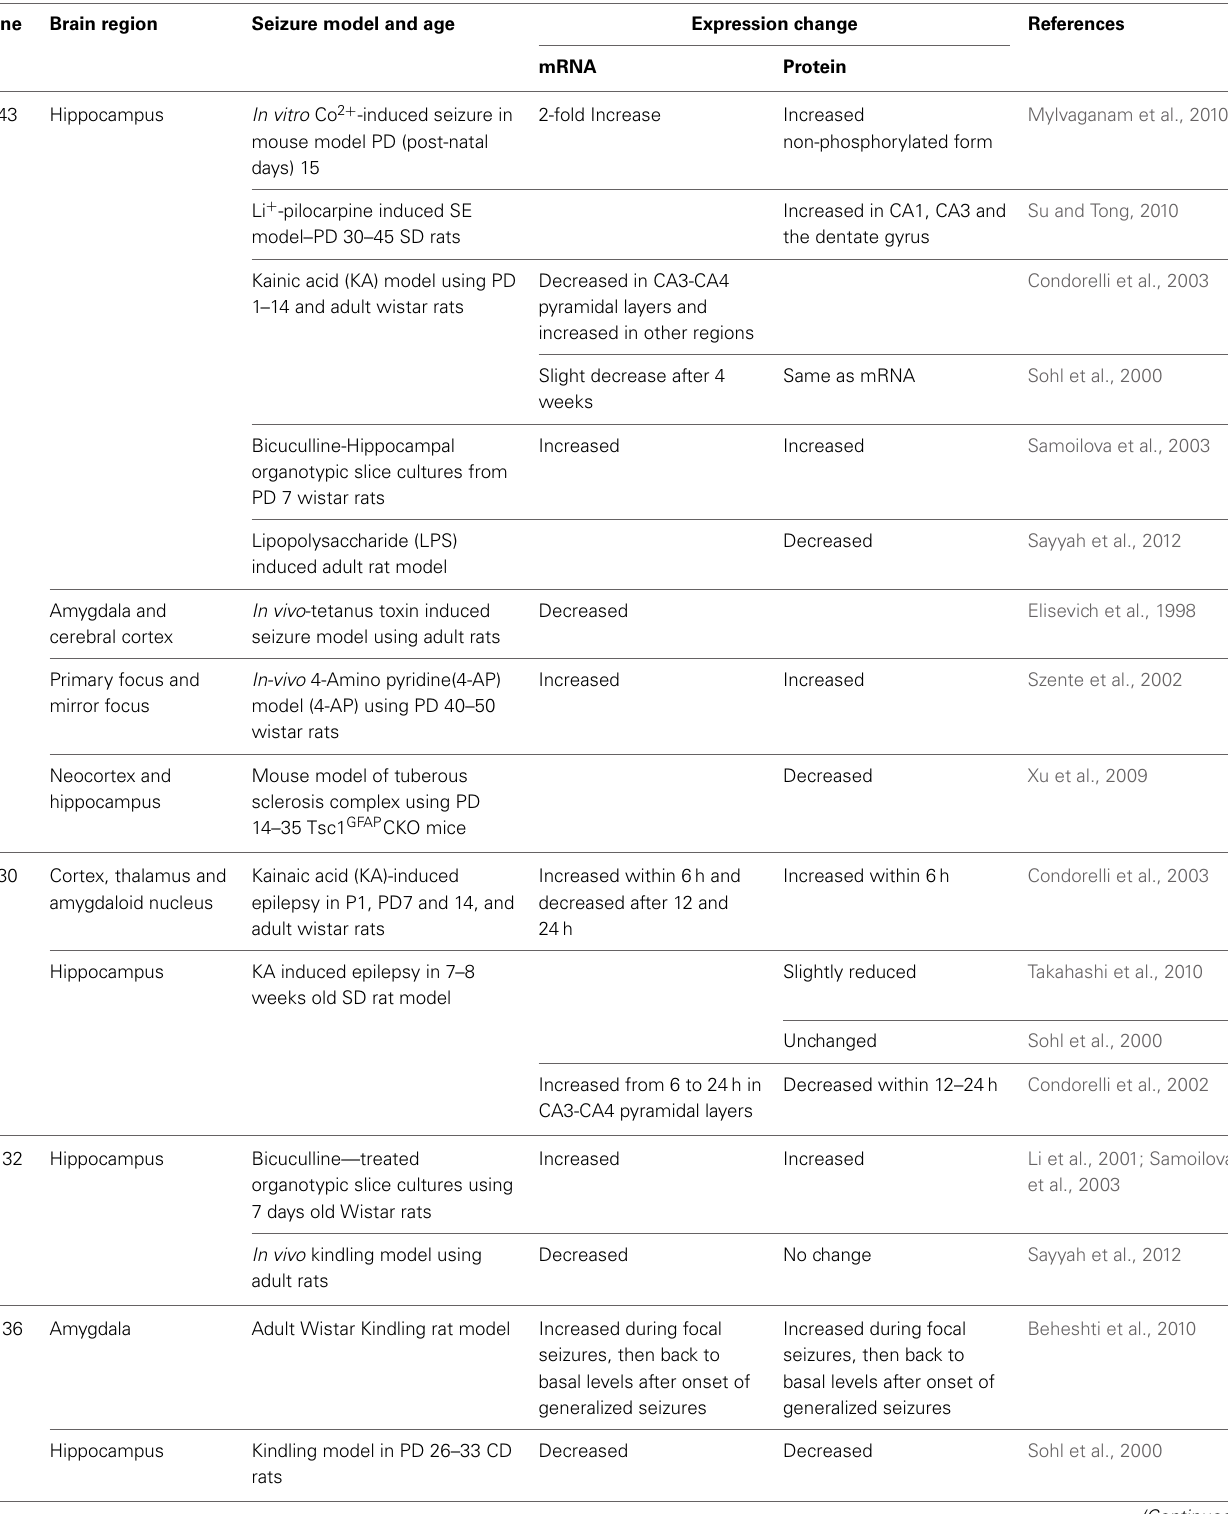
Table 1 | Connexin and pannexin expression changes associated with experimentally-induced seizures in different rodent models.